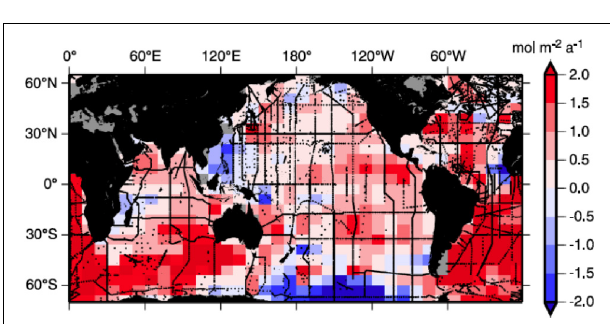
FIGURE 2 | Column inventory changes in anthropogenic carbon in the global ocean based on the CARINA and PACIFICA syntheses from Kouketsu and Murata